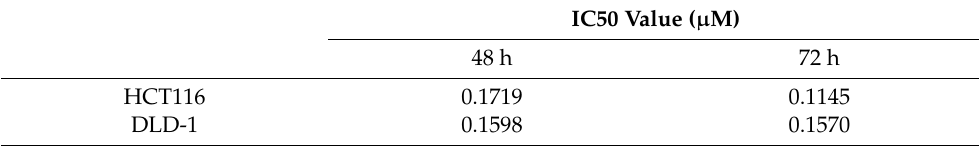
Table 1. IC50 value.